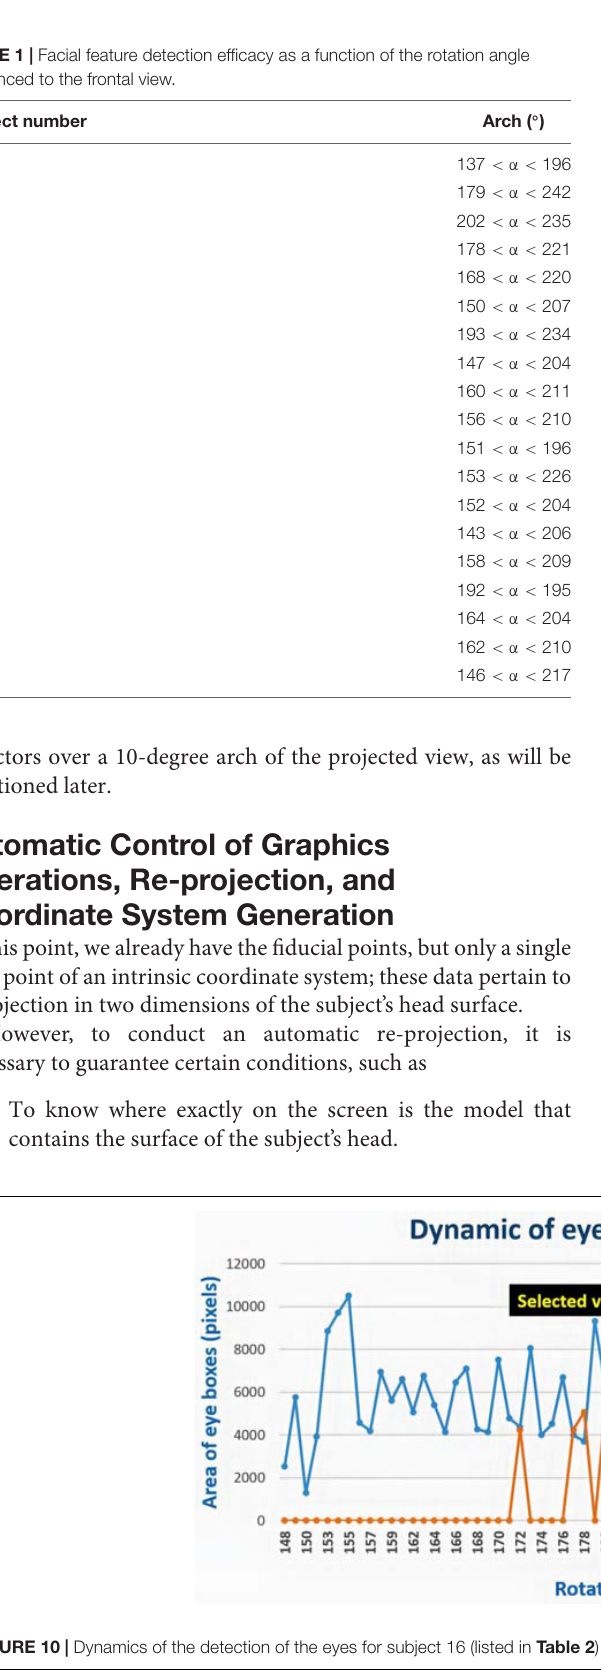
Frontiers in Neuroscience |